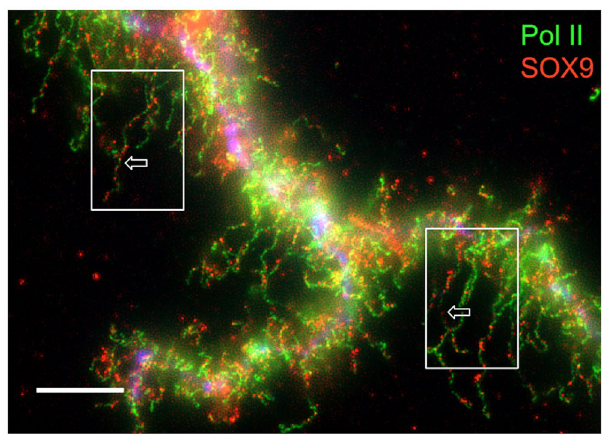
Figure 6. Immunostaining of Pol II and SOX9 in P. waltl LBCs. Nuclear spreads were immunostained for SOX9 with the anti-Cter-SOX9 antibody (red, Alexa 568 IgG) and for Pol II with the mAbH14 (green, Alexa 488 IgM). Pol II immunostaining was continuous over the loop axis while that of SOX9 was concentrated on granules distributed above the loop axis. This double immunostaining pattern was particularly visible on the two lateral loops indicated by arrows in the boxed areas. The intensity of fluorescence in this experiment was normalized with respect to its relevant controls (i.e., secondary antibodies alone). The image was deconvoluted (see Figure S7 for the non deconvoluted image). Wide field Leica microscope. Scale bar: 10 μ